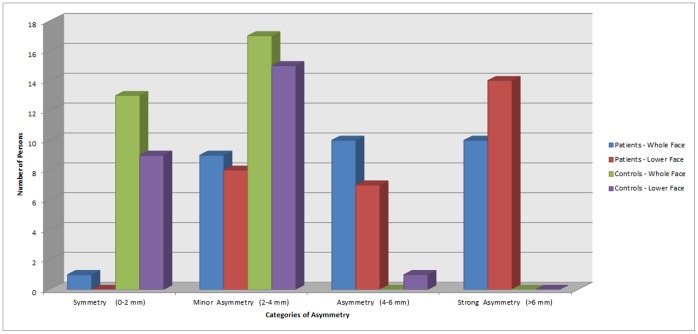
Histogram of the number of persons per category based on the 95th percentile.